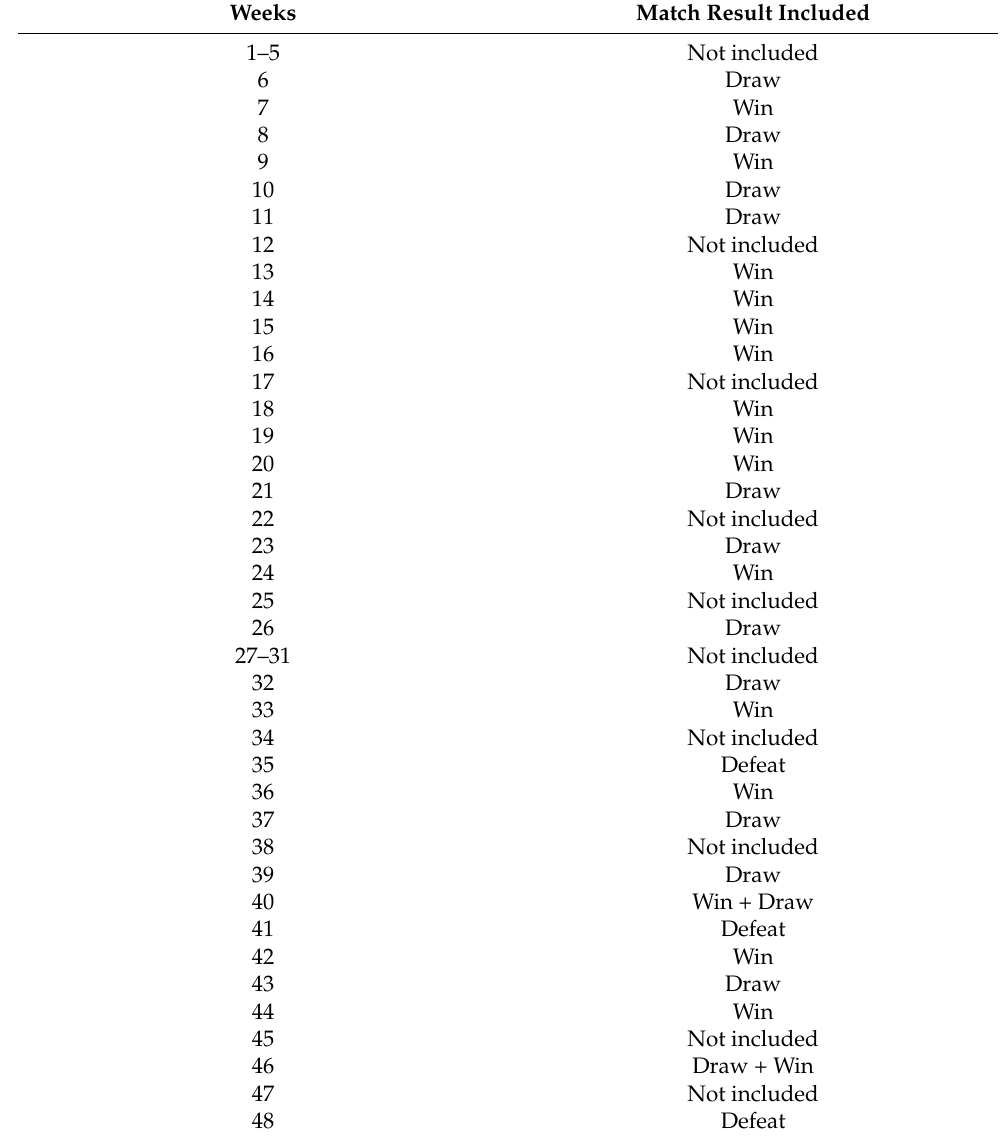
Table 1. Characterization of the weeks and matches included for